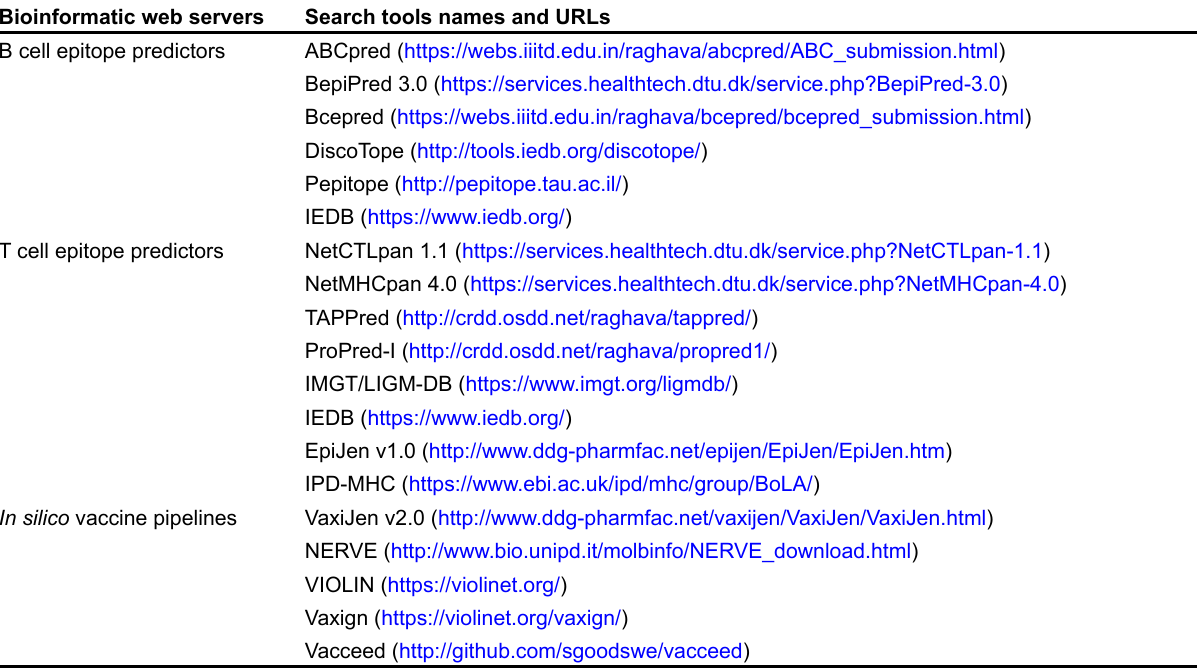
Table 2. Search tools, bioinformatic web server names, and URLs necessary to predict subcellular localization, protein structure, immunogenic characteristics, and some other desirable features for vaccine development ( continued